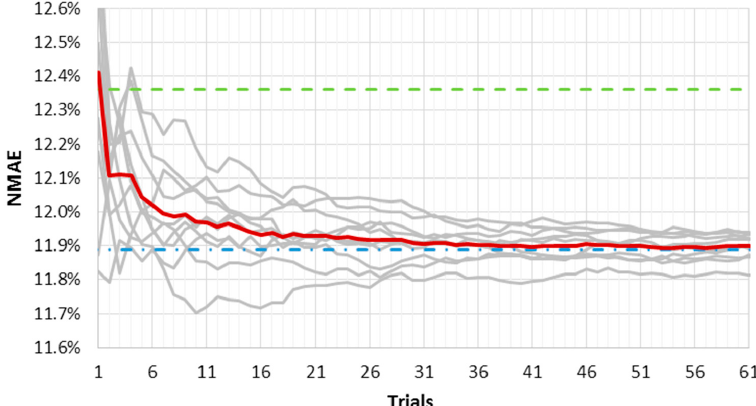
Figure 3. NMAE % of ten random ensemble (grey lines) as a function of the growing number of trials. The artificial neural network (ANN) has 120 neurons and an “LM fast” training algorithm. The mean of the ten ensemble forecasts NMAE p is in red, the mean NMAE % of one thousand forecasts is the dashed green line, and the ensemble NMAE % of one thousand forecasts is the dash-dotted blue line.